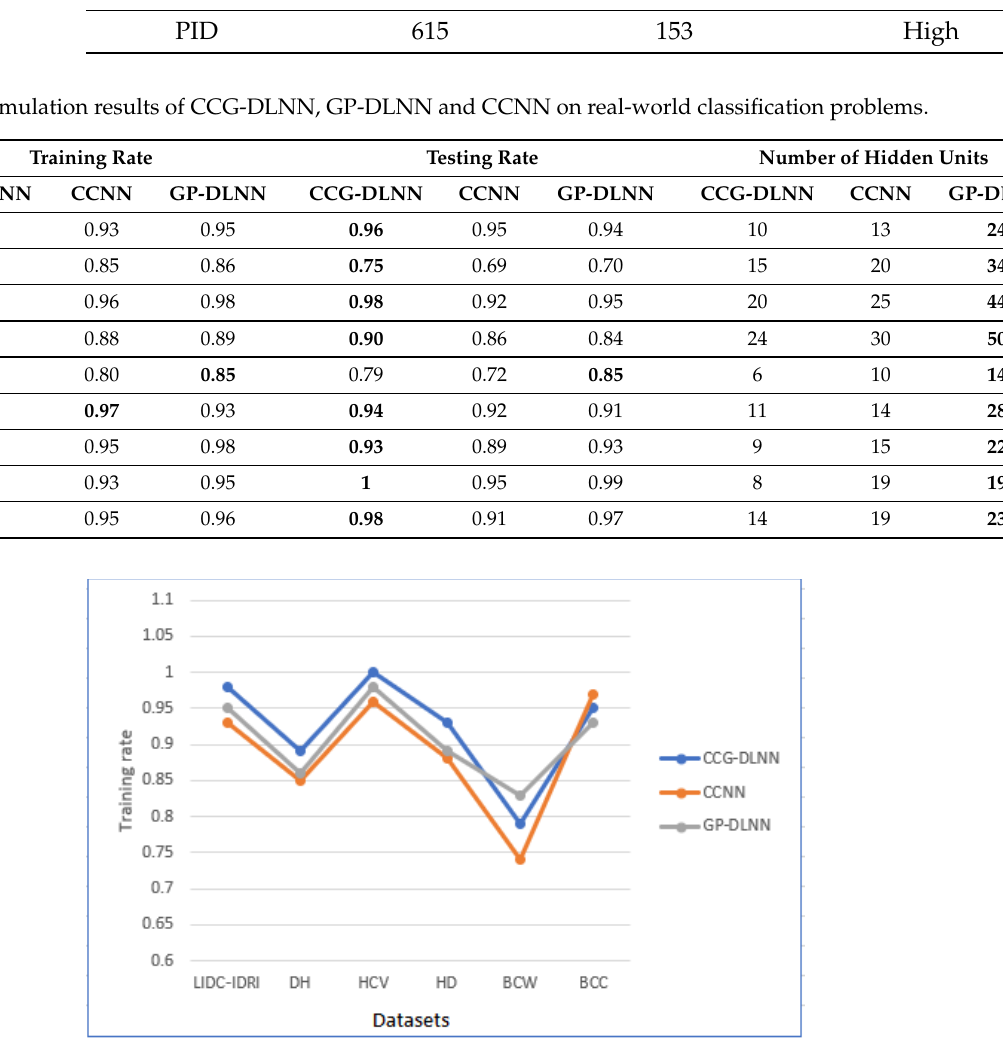
Figure 9. Curves of training rate obtained by CCG-DLNN, GP-DLNN and CCNN on real-world classification